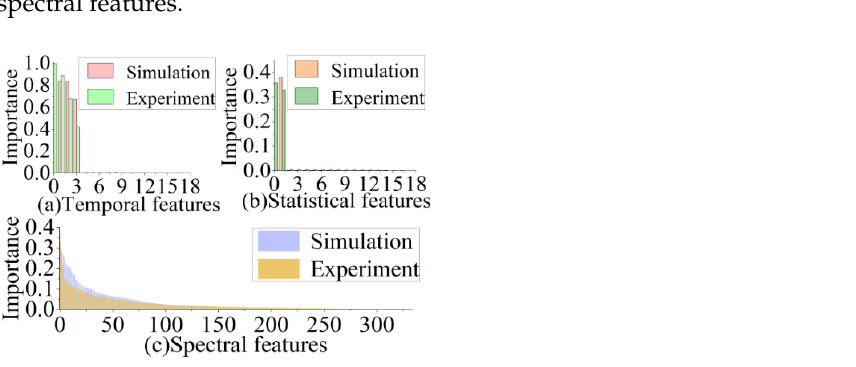
Figure 7. ( a ) SMI signal obtained with an optical platform with A = 2.075 µm and f = 25 Hz. ( b ) The waveform of an actual SMI signal with wavelet transform. ( c ) Fourier transform of SMI signal after wavelet transform. ( d ) STFT of SMI signal. Hamming window; window points: 256; overlapping points: 128.